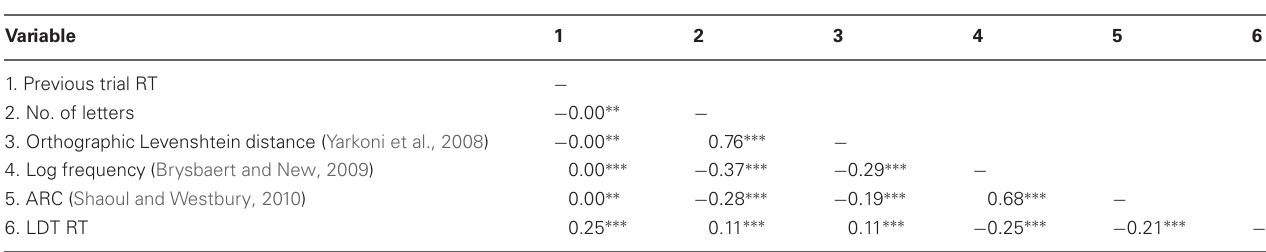
Table 1 | Correlations between centered predictor variables and dependent variable for 25,463 words.